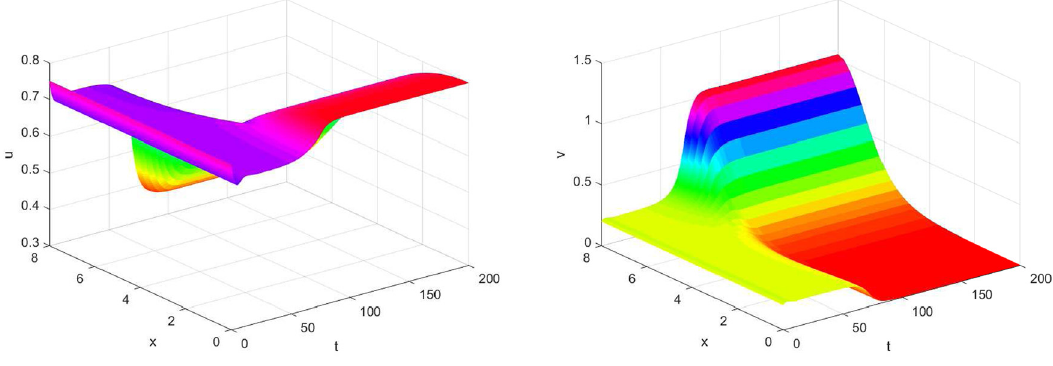
Figure 5: Phase portraits of ( 1.5 ) with parameters = becomes unstable.